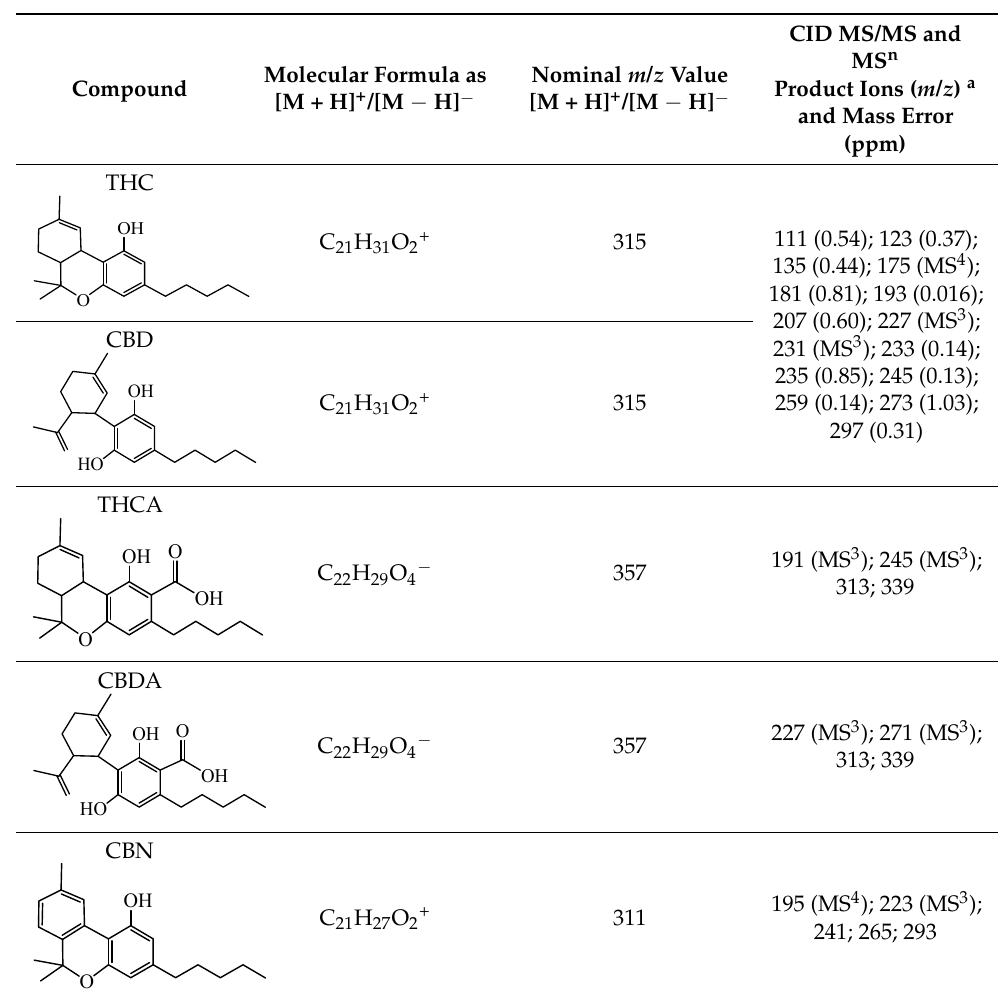
Figure 2. HPLC-UV chromatographic profile of an extract of cannabis inflorescences at 220 nm: ( A ) Mary Moonlight-Legal Weed diluted 1:10; ( B ) Purple Rock-Legal Weed; and ( C ) Alexis Haze-Legal Weed diluted 1:10. Cannabinoid contents of 34 Cannabis sativa L. samples of industrial hemp are re- ported in Table 3. As expected, cannabinoid levels were heterogeneous among the samples, because they can fluctuate in response to genetic and environmental factors. THC, CBD, and CBDA were the major cannabinoids with concentration levels in the ranges of